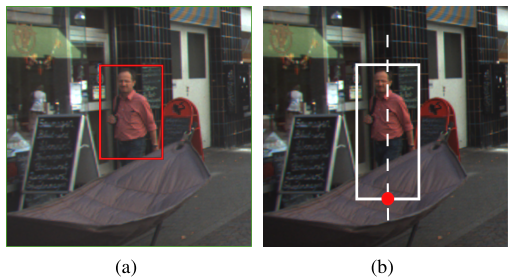
Figure 5. The detected 2D bounding box (a) is corrected using the back-projected foot point from 3D